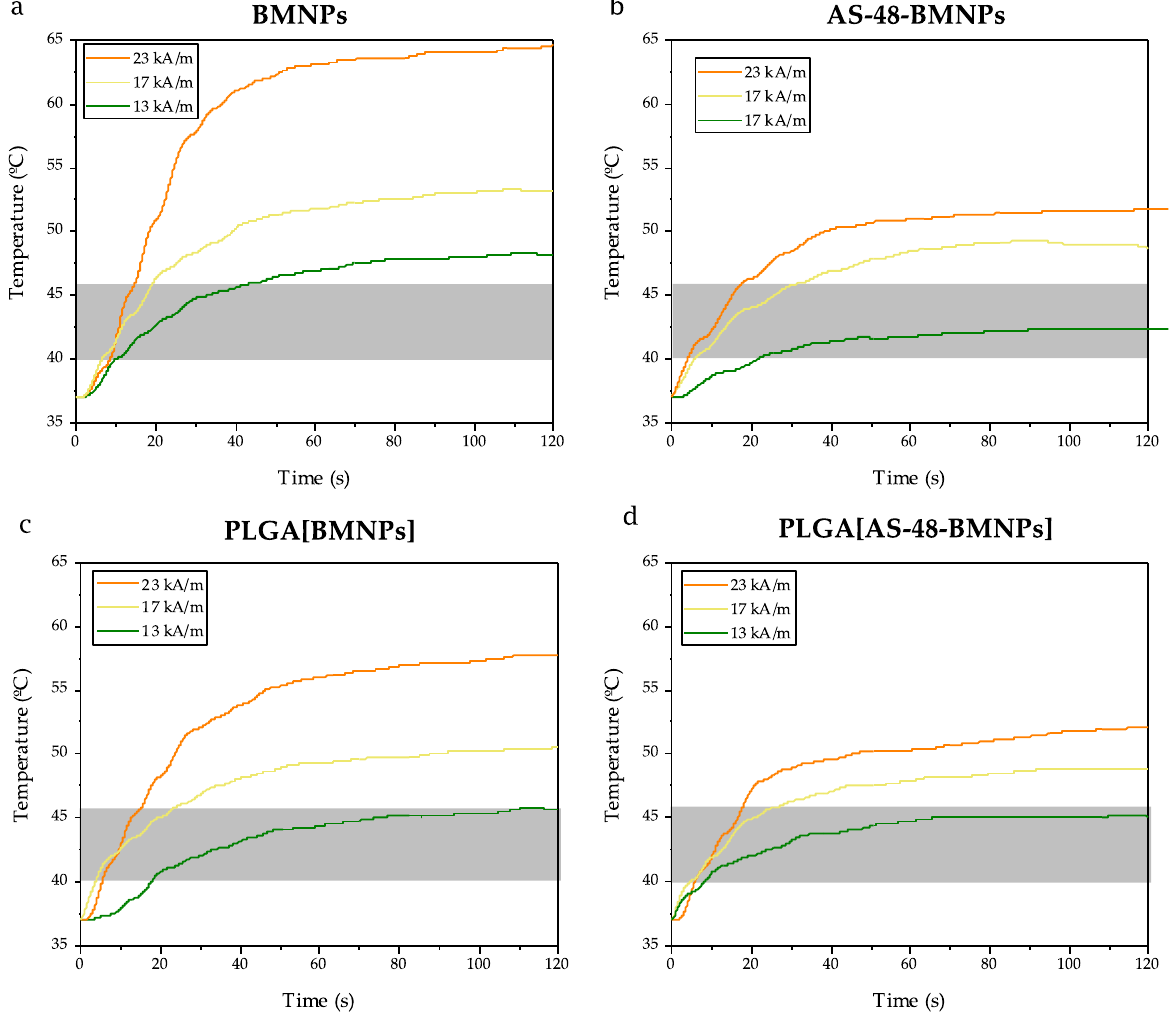
Figure 4. Time evolution of the temperature increase caused by ( a ) BMNPS, ( b ) AS-48-BMNPs, ( c ) PLGA[BMNPs], and ( d ) PLGA[AS-48-BMNPs] following exposure to AMF of different magnetic field strengths (13, 17, 23 kA/m) at a fixed frequency of 120 kHz. The transparent grey band shows the therapeutic temperature.